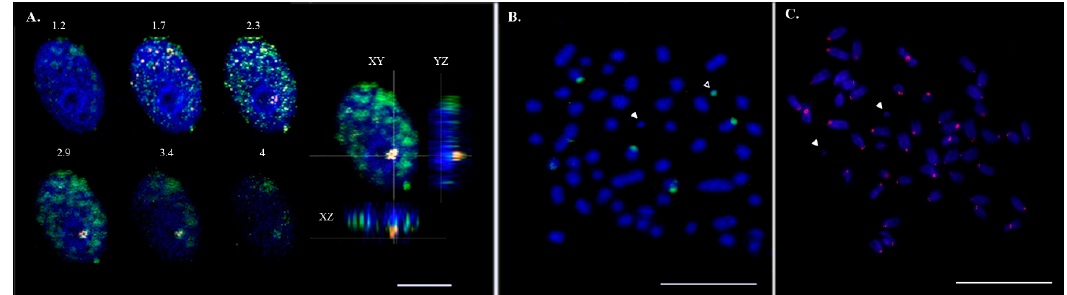
Figure 2. Micro-dissected B chromosome-derived probes associated with the nucleolus and 18S rDNA were detected on both A and B chromosomes of the Asian seabass. ( A ) Hybridization of Bchr6 painting probes on primary fibroblast cell nuclei. Confocal section with a 0.5 μ m step and three nuclear projections (XY, YZ, XZ). Micro-dissected probes of Bchr6 (red), anti-5-methylcytosine AB (green). Nuclei were counterstained with DAPI (blue). The bar is 5 μ m. ( B ) B chromosomes with and without 18S rDNA (green signal). White arrowheads indicate a Bchr without 18S rDNA; empty arrowheads indicate a Bchr with an 18S rDNA signal. The bar is 5 μ m. ( C ) Histone H3-like centromere protein A (CENP-A) stained chromosomes (red signal). White arrowheads indicate a Bchr without CENPA. The bar is 5 μ m.